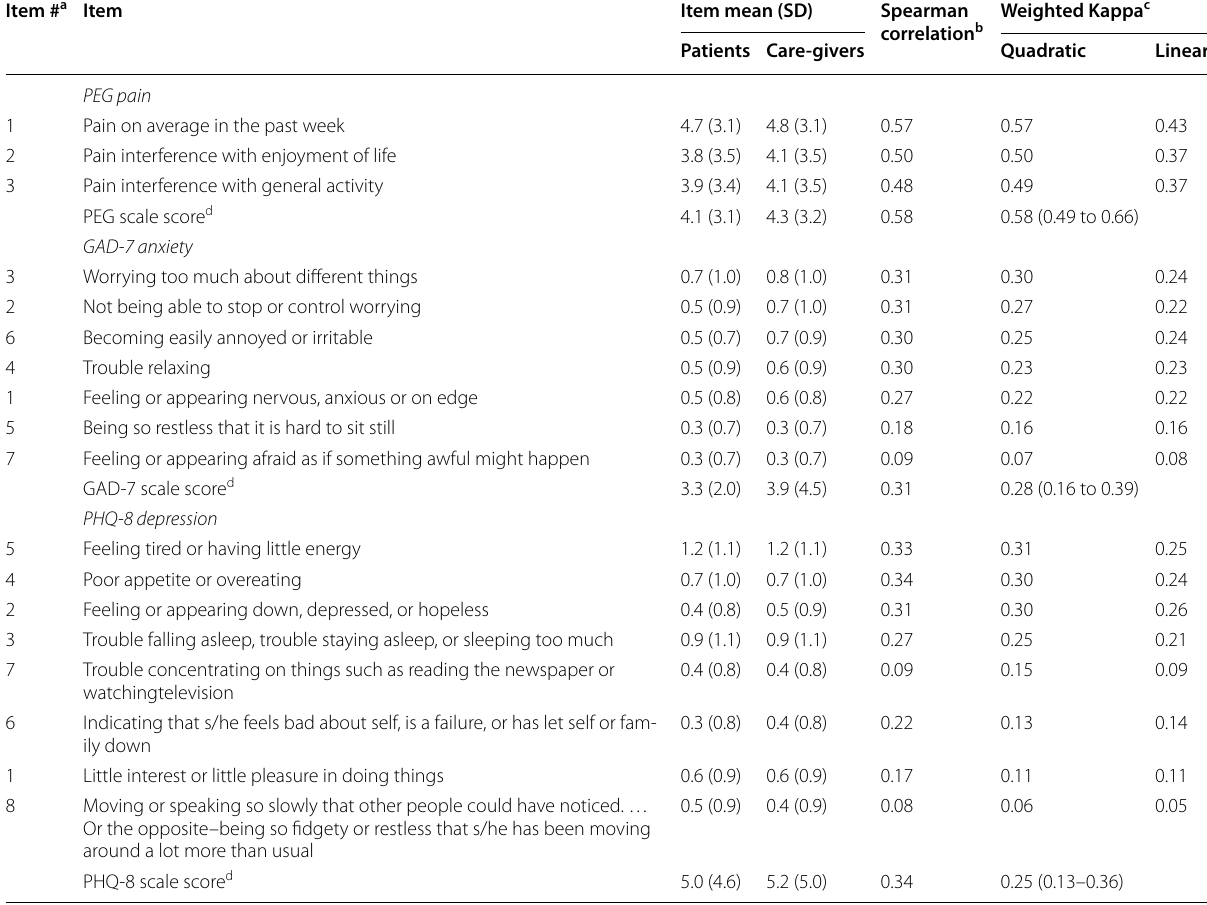
a Items for each scale are ordered in table from highest to lowest quadratic weighted kappa b Most of the Spearman correlations are highly significant (p < .0001) except for items only significant at p < .05 (PHQ-8 items 1, 6; GAD-7 items 1, 5) or those not significant (PHQ-8 items 7, 8; GAD-7 item 7) c All weighted kappa values are significant (i.e., 95% CI does not include 0) except for GAD-7 items 5 and 7 and PHQ-8 items 1, 6, 7 and 8 (quadratic and linear) d For scale scores, the value under the weighted kappa column is the Intraclass Correlation Coefficient (ICC) with 95% CI, calculated using the absolute agreement version of the ICC and specifying rater (patient vs their caregiver) as a fixed